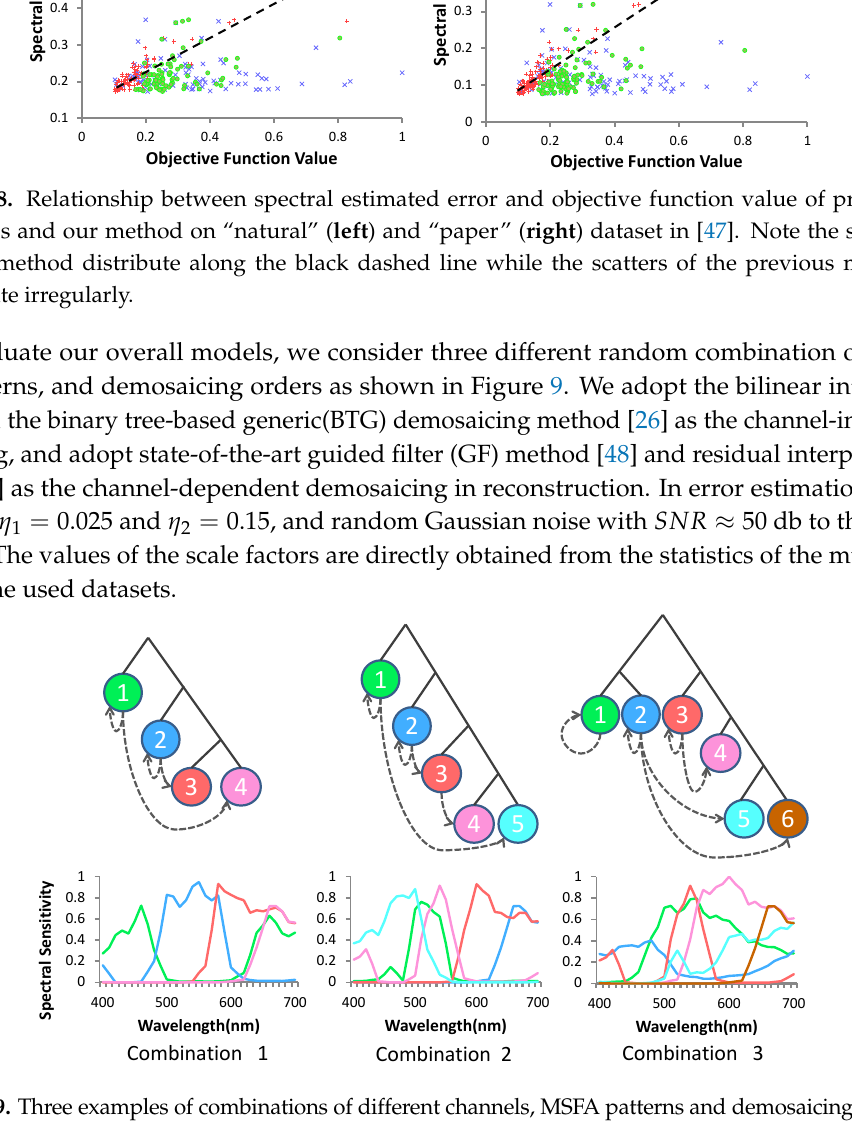
Figure 9. Three examples of combinations of different channels, MSFA patterns and demosaicing orders. Note that the three examples have different numbers of channels (4, 5, 6). The combinations are set casually to verify our overall